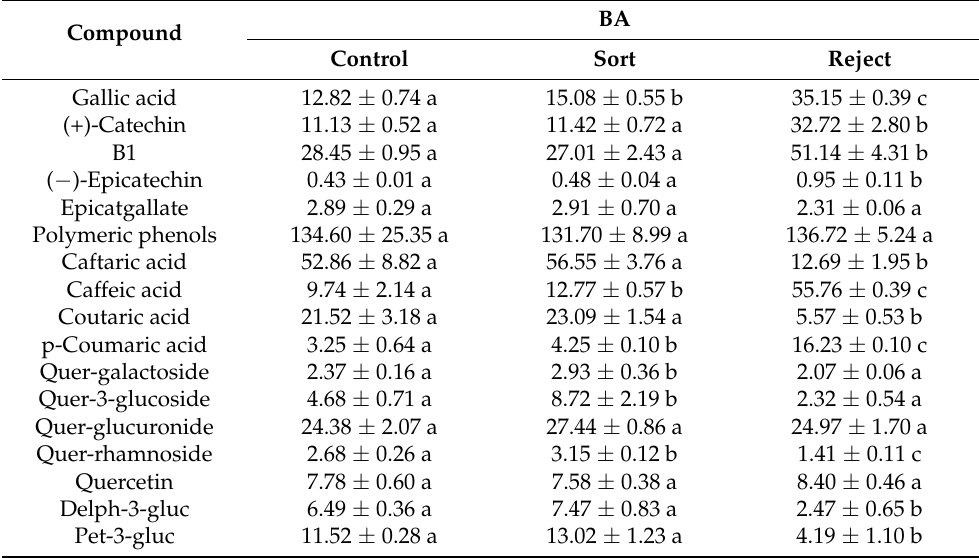
Table 8. Concentration (mg/L) of phenolic compounds in Barbera wines determined by RP-HPLC from samples taken around six months after